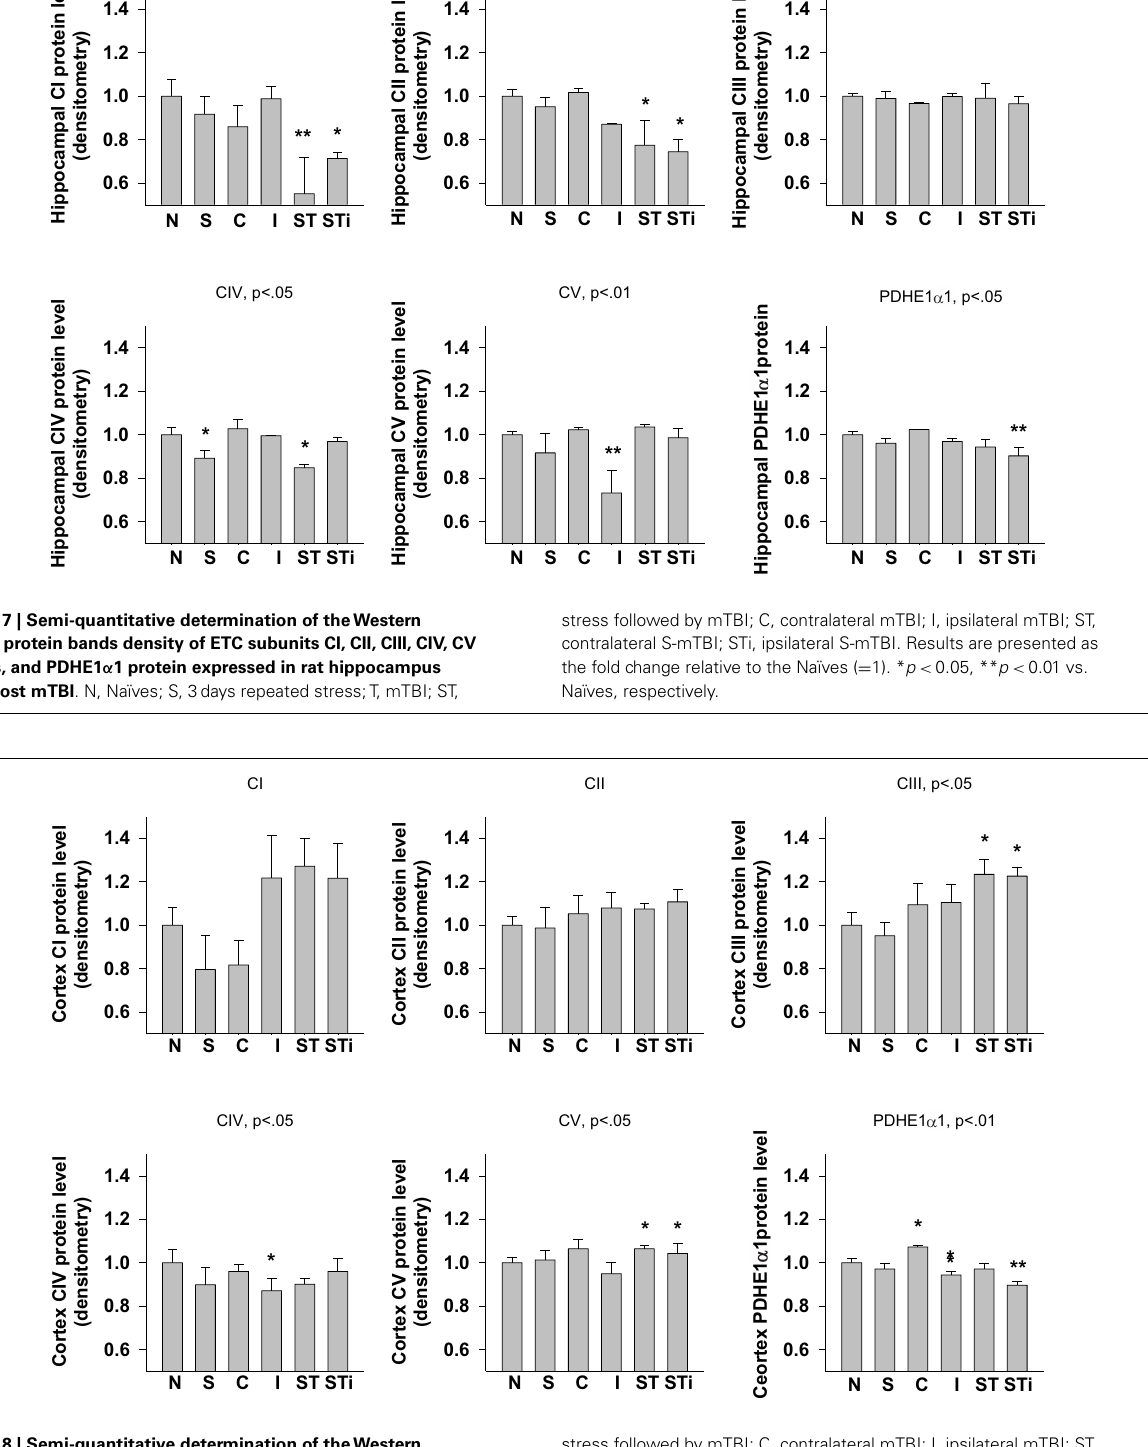
FIGURE 8 | Semi-quantitative determination of theWestern blotting protein bands density of ETC subunits CI, CII, CIII, CIV, CV proteins, and PDHE1 α 1 protein expressed in rat cerebral cortex 7days post mTBI . N, Naïves; S, 3days repeated stress;T, mTBI; ST,